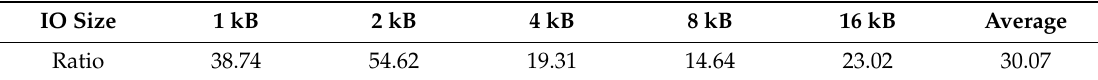
Table 3. The IOPS of proposed file system.